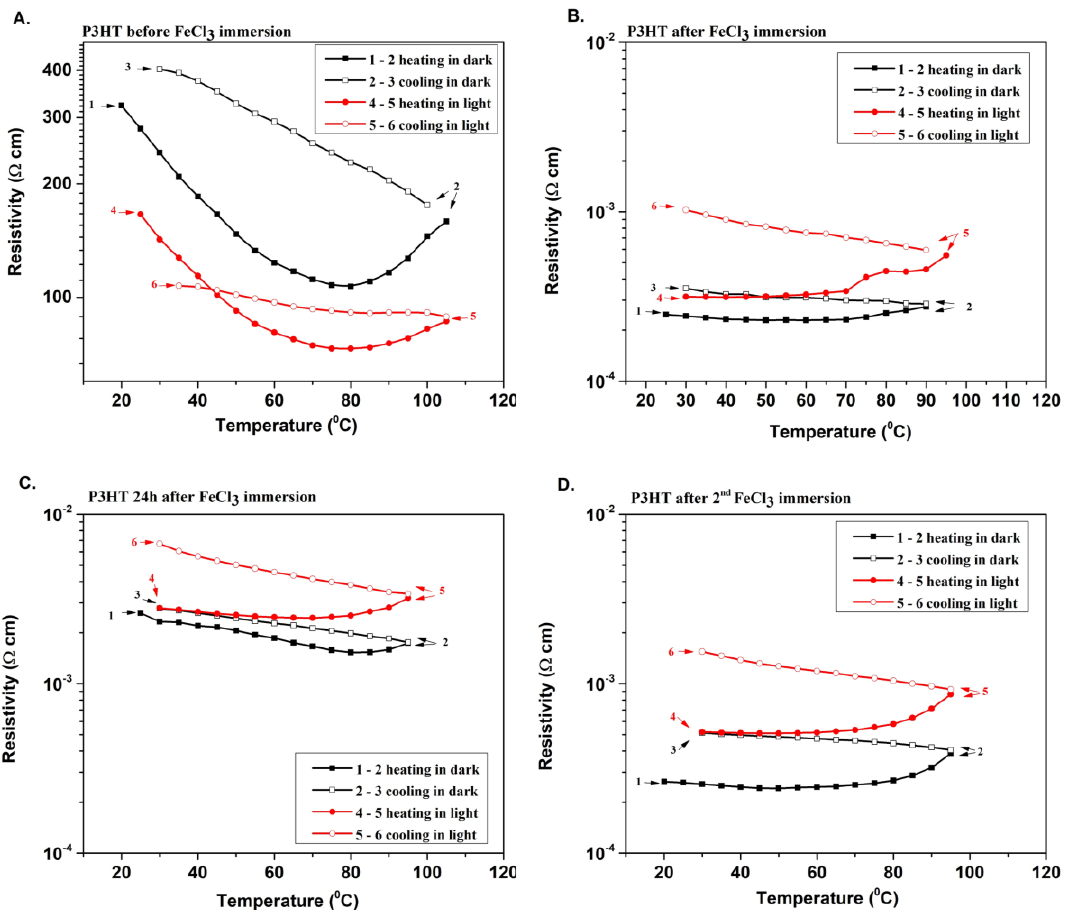
Figure 6. Temperature dependence of resistivity during heating (filled dots) and cooling (empty dots) cycles, under dark (black squares) and light (red stars) conditions: ( A ) before FeCl 3 immersion, ( B ) immediately after immersion, ( C ) 24 h after immersion, and ( D ) after the second immersion).